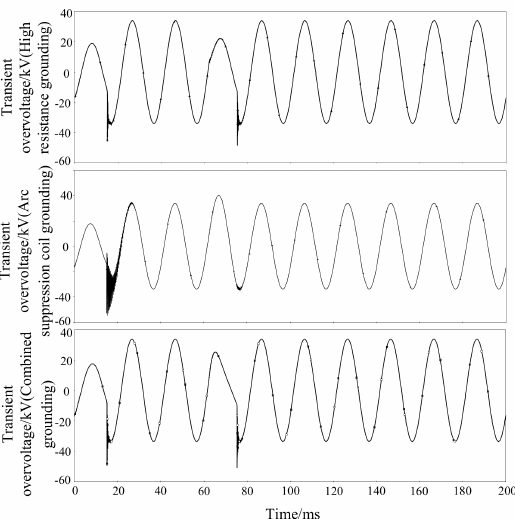
Figure 6. Sound phase transient voltage in the case of a single-phase grounding